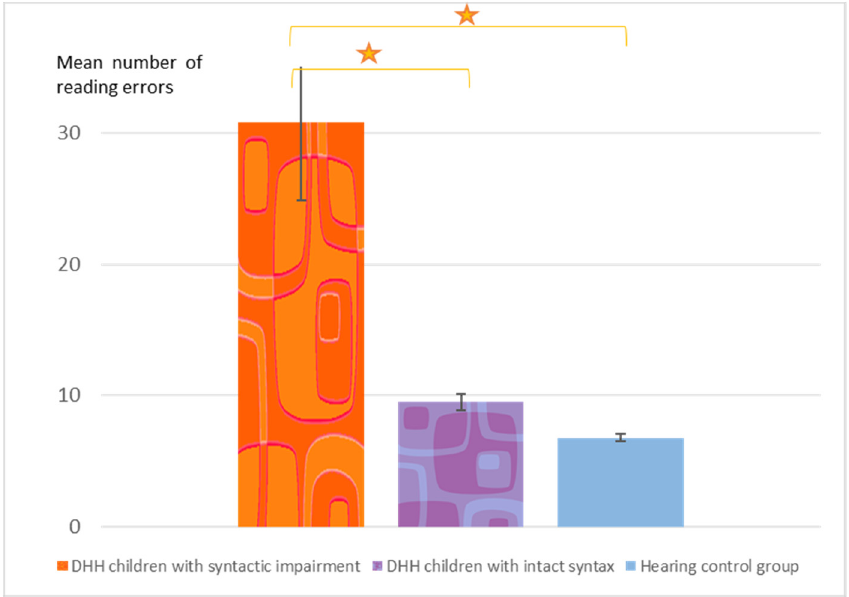
Figure 1. Mean number of reading errors (and SD bars) in paragraphs with syntactic movement in the three groups (out of 56 sentences, 48 of which included movement). Pentagram: p < 0.0001